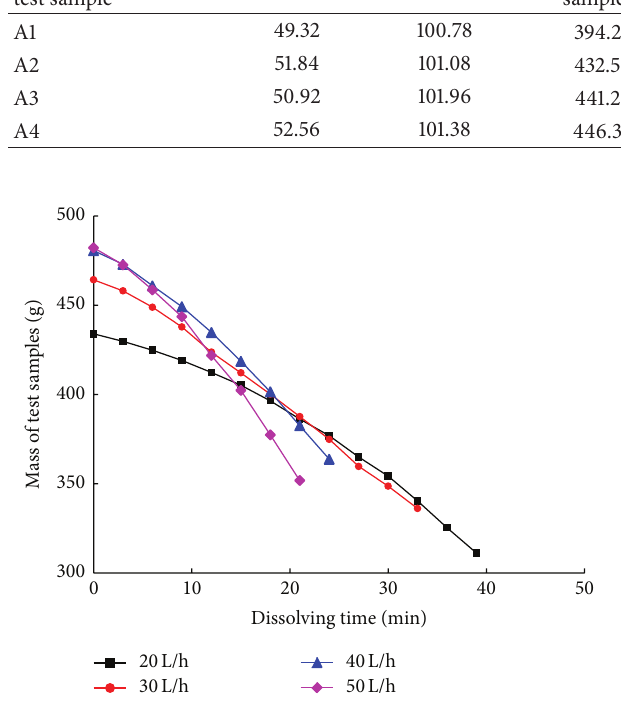
Figure 3: The curve of test specimen’s mass under different flow quantity.